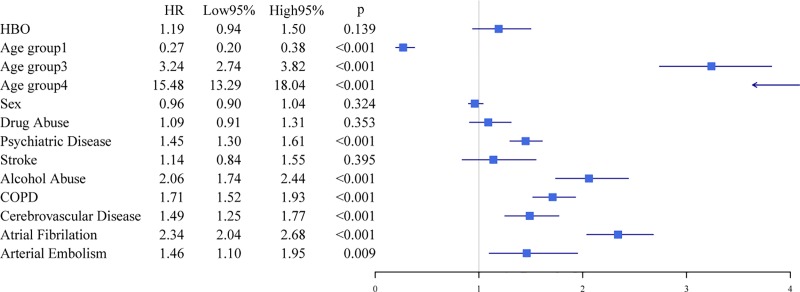
Forest plot for the Cox proportional hazards model.Age group 1 = 0–24.4 years, age group 2 (reference) = 24.4–36.6 years, age group 3 = 36.6–50.75 years, and age group 4 = 50.8+ years. COPD = Chronic Obstructive Pulmonary Disease. Lines illustrate 95% CI.